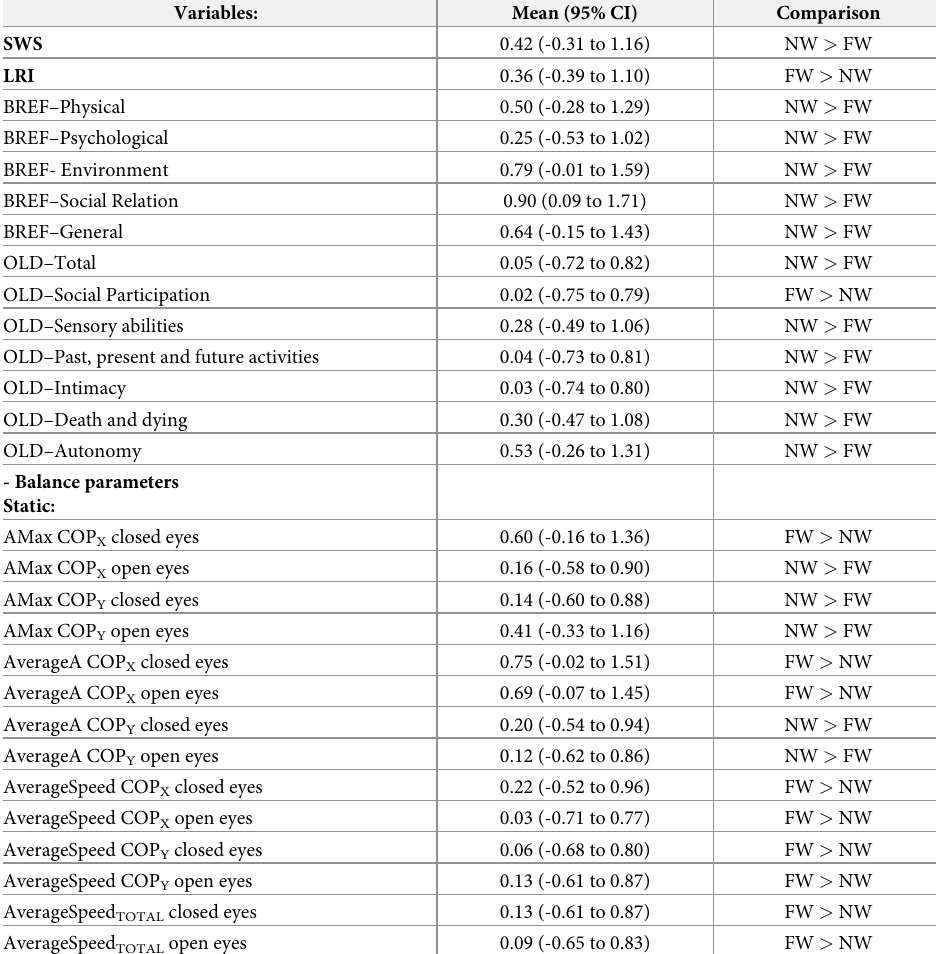
Table 4. Effect size results of post-intervention comparisons of NW and FW groups (left column). Values in mean and lower and upper limits of 95% Confidence Interval, for the SWS, LRI, quality of life questionnaire and static balance parameters. Comparison of means between groups is in the right